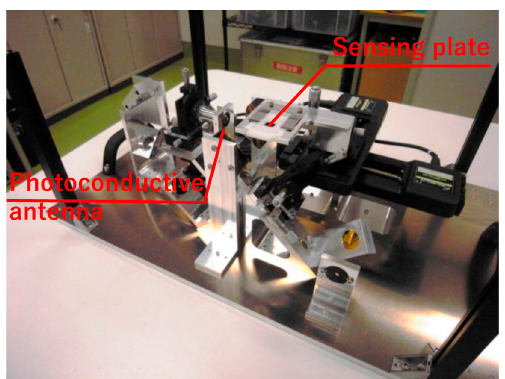
Figure 4. Schematic of the optical setup of the TCM.